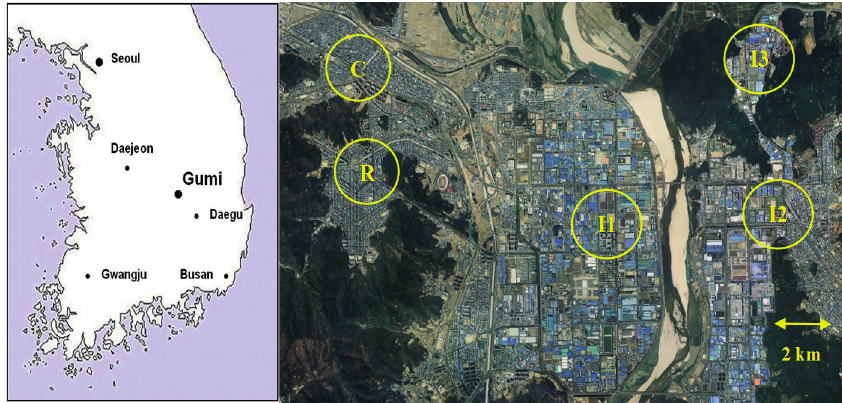
Figure 1. Locations of Gumi City in Korea and sampling sites in the city: I1—industrial site I, I2—industrial site II, I3—industrial site III; R—residential site; C—commercial